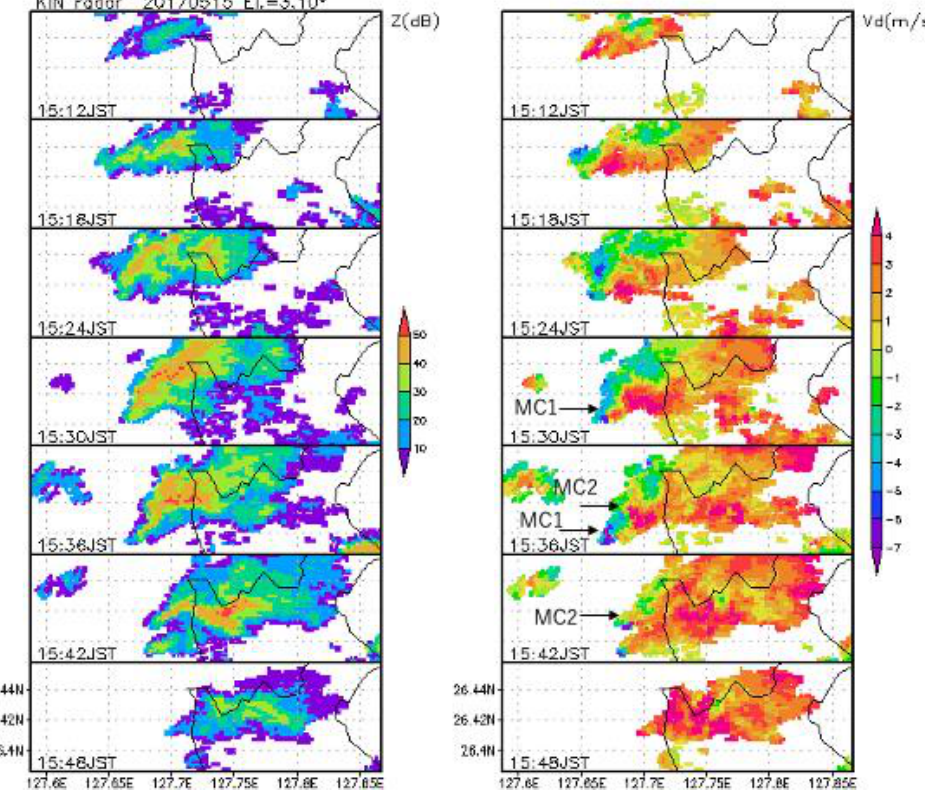
Figure 3. Radar reflectivity field ( left ) and Doppler velocity field ( right ) from KIN radar (elevation angle = 3.1°) from 15:12 to 15:48 JST. The local maximum/minimum pairs of Doppler velocity which correspond to two misocyclones (MC1 and MC2) analyzed in this study are indicated by arrows.